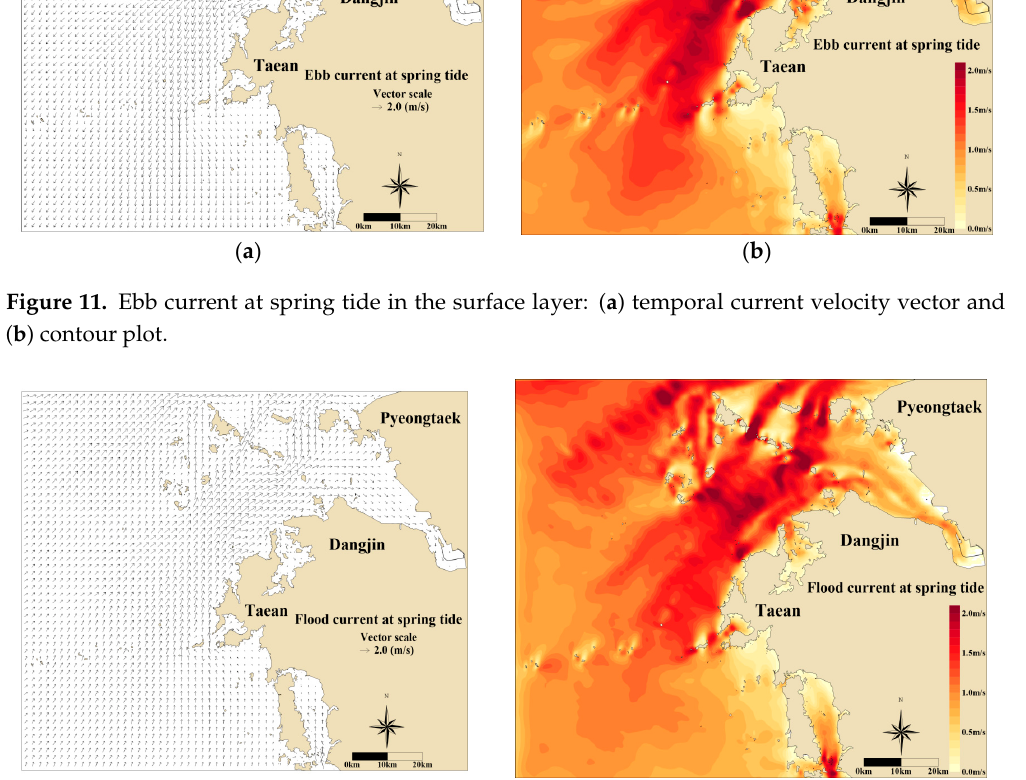
Figure 12. Flood current at spring tide in the bottom layer: ( a ) temporal current velocity vector and ( b ) contour plot.